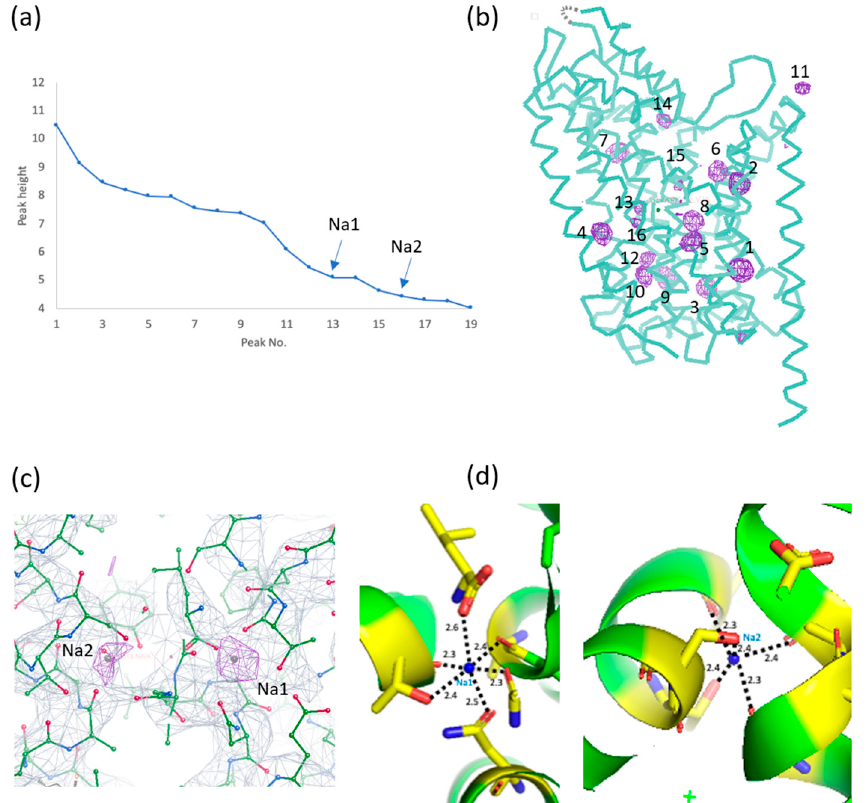
Figure 3. Characterization of Na + in LeuT. ( a ) A plot of the 19 highest Bijvoet ‐ difference Fourier peaks in LeuT. Two Na + peaks are indicated by arrows. ( b ) Bijvoet ‐ difference Fourier peaks are shown as purple isomeshes contoured at 3.5 σ . The refined LeuT model is shown as sticks. Sulfur peaks for methionine residues are 1, M363; 2, M403; 3, M65; 4, M199; 5, M360; 6, M394; 7, M44; 8, M176; 9, M452; 10, M18; 12, M59. Peaks 13 and 16 are for Na1 and Na2, respectively. Peaks 11 and 14 were identified as Cl − ( c ) Electron densities (magenta isomeshes contoured at 4 σ ) for two Na + in LeuT. 2Fo ‐ Fc electron densities are shown as grey isomeshes contoured at 1.5 σ . ( d ) Na + ‐ binding sites in LeuT. Residues and leucine forming the Na + ‐ binding sites are shown as sticks. Distances (Å) between Na + and the bound atoms are shown as dash lines.